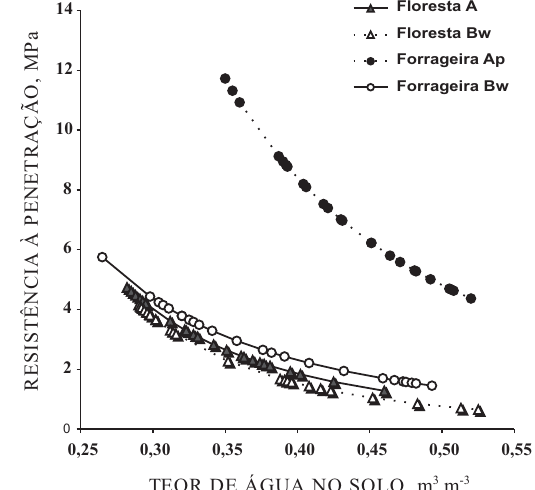
Figura 3. Variação da resistência do solo à penetração em função do teor de água dos horizontes superficial e subsuperficial dos solos sob mata nativa e forrageira